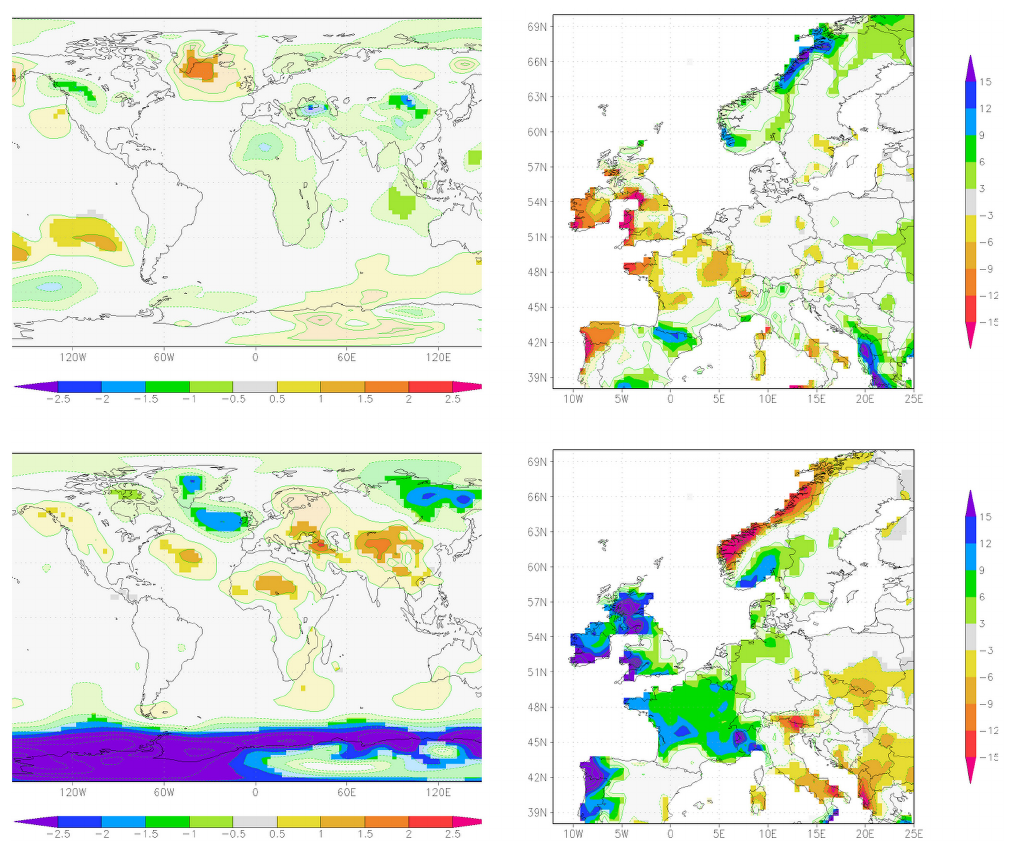
Figure 8. Top left panel: global PMSL anomalies (hPa) in winter half-year for the tripole SST index < − 1SD in the previous May. Top right panel: rainfall anomalies in winter half-year (mmmonth − 1 ) over the UK and nearby Europe for tripole SST index < − 1SD. Bottom left panel: as top left panel for > 1SD. Bottom right panel: as top right panel but for the tripole SST index > 1SD in the previous May. Areas significant at the 5% level are darkly coloured. Tripole SD calculated for May 1949–2008. PMSL comes from the NCEP